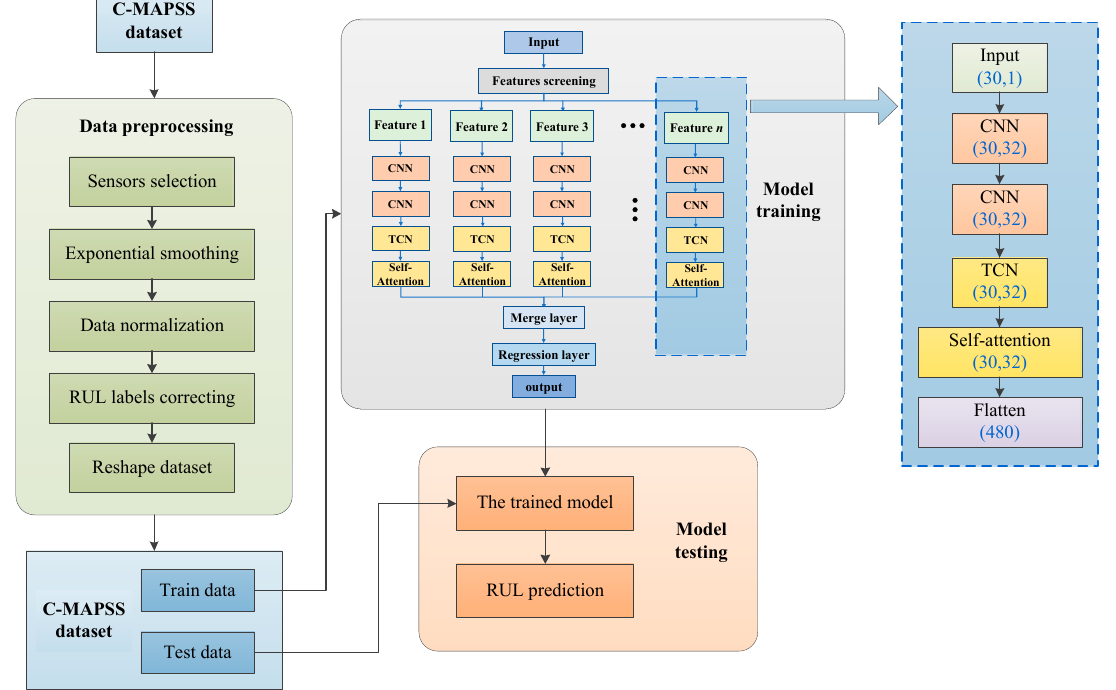
Figure 3. RUL prediction process of aeroengines.